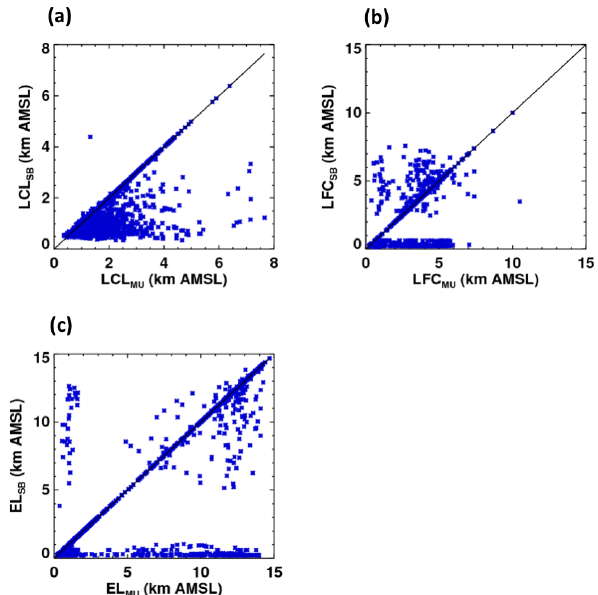
Figure 10. Scatterplots of convective levels, computed using RH- corrected soundings, comparing estimates for surface parcel charac- teristics defined by the level with the maximum virtual temperature in the lowest kilometer (MU) and the lowest level in the sounding (SB) for (a) LCL, (b) LFC and (c) EL.